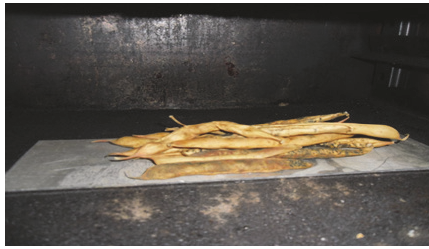
Figure 6: Common beans oven drying.